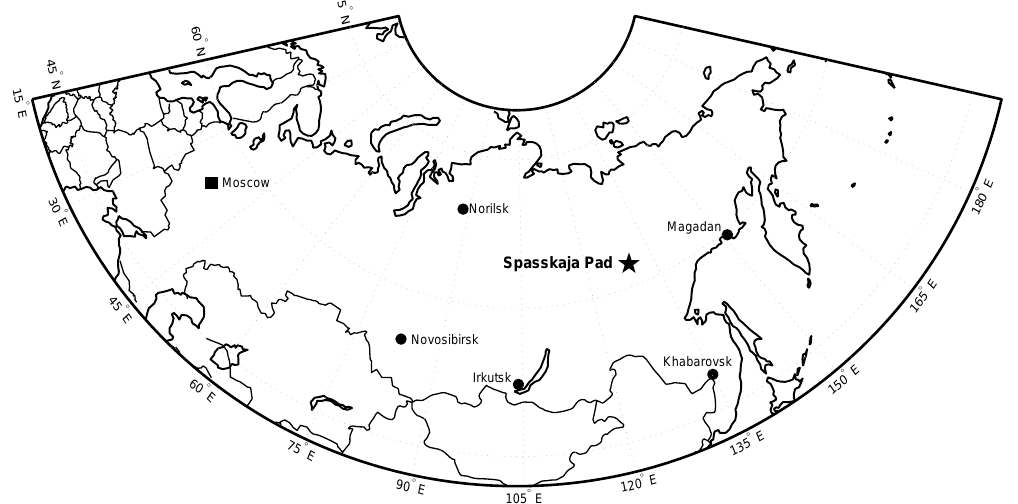
Fig. 1. Map showing the location of the Spasskaya Pad measurement site.